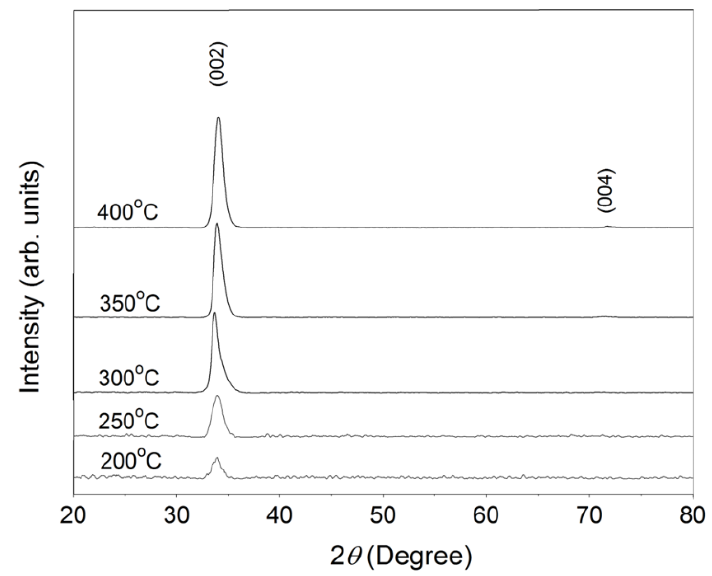
Figure 2. XRD patterns of WZO films deposited under different growth temperatures (200 – 400 °C).